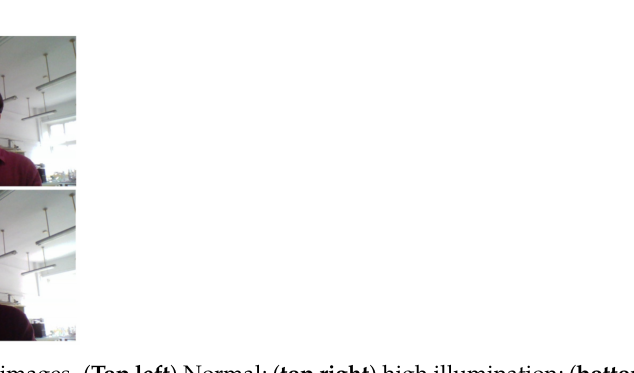
Figure 13. Different illumination images. ( Top left ) Normal; ( top right ) high illumination; ( bottom left ) middle illumination; ( bottom right ) low Illumination.